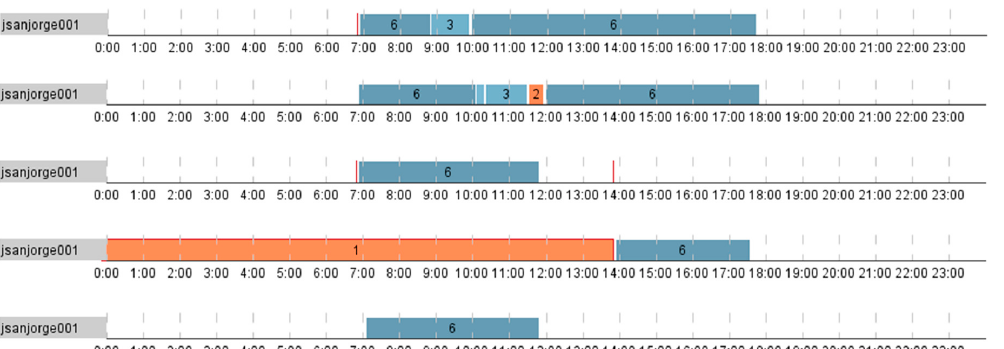
Figure 12. The graph of visited zones by the employee of the Executive department.